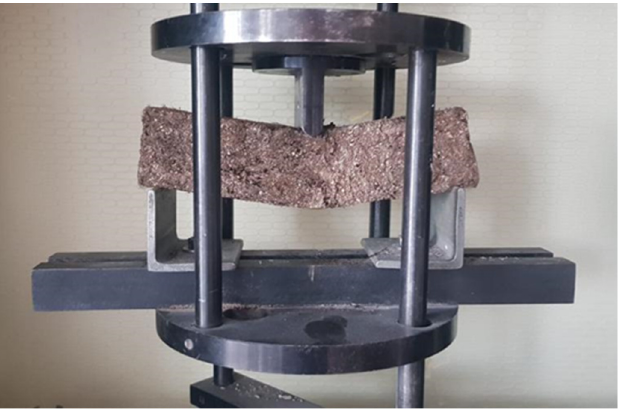
Figure 4. Test of bending resistance of a sample of sapropel, flax fiber, and vermiculite composite materials.